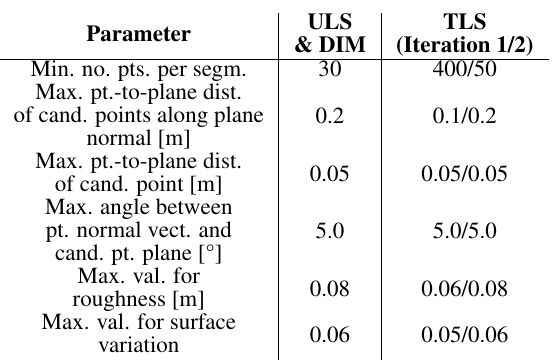
Table 2. Segmentation parameters used to extract planar areas from UAV-borne laser scanning (ULS), UAV-borne photogrammetry using dense image matching (DIM), and terrestrial laser scanning (TLS) point clouds. A second iteration is applied to TLS point clouds to increase the spatial coverage of segmented planes by using less strict parameter settings. Due to a more uniform point spacing, only one iteration of segmentation was applied to ULS and DIM point clouds. For each pair, we compute M3C2 distances between two point clouds at so-called core points. These core points (ca. 39 mil- lion points) represent a subset of the ULS 2019 point cloud and are distributed uniformly (point spacing 0.05 m) over the lower tongue area of the rock glacier (Figure 1). Using the ex- act same core points as input for all pairwise change compu- tations ensures that change analysis results of M3C2 are com- parable. While change is quantified for core points, the full information of the compared point clouds is used for estima- tion of magnitudes of change and the associated LoDetection. For all M3C2 change analyses we use the same parameters